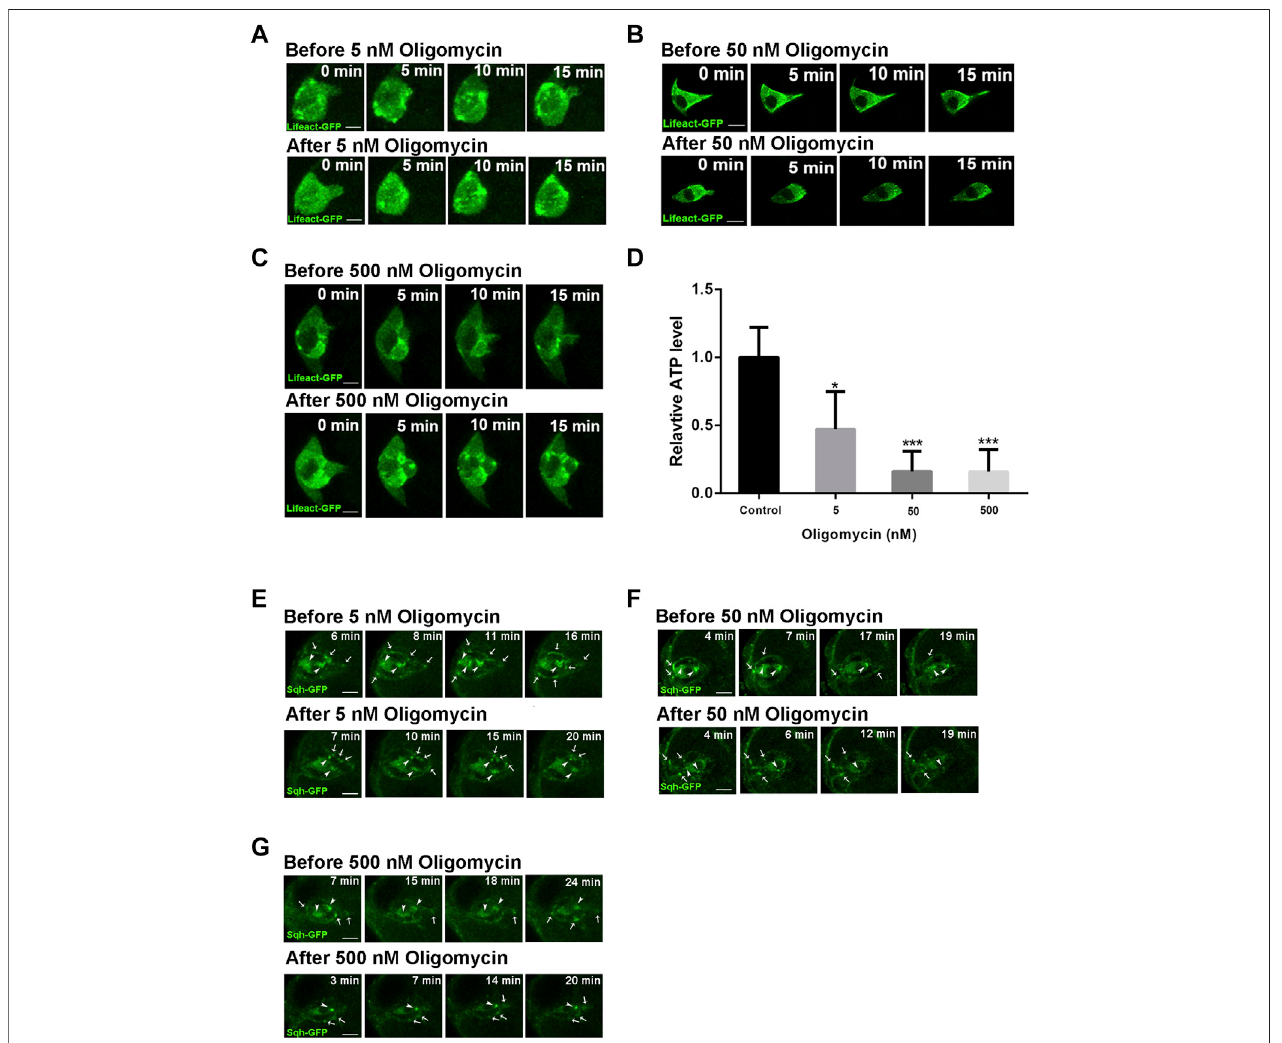
FIGURE 3 | Actin and myosin dynamics are affected by ATP level reduction during border cell migration. (A – C) Before treatment of early stage nine egg chambers by 5,50,and 500 nM Oligomycinrespectively, theborder clusters undergodynamiccellshape changes,extend longleadingprotrusion, and exhibitstrong dynamics of F-actin enriched patches. Less than 5 min after Oligomycin treatment, border cell clusters retract the leading protrusion and shape change and dynamic movement of F-actin patches were much reduced, with the effects by 50 and 500 nM treatment (B,C) more severe than that by 5 nM treatment (A) . See Supplementary VideosS5 – 10 formore details. (D) The ATPlevels ofovaries weresigni fi cantlydecreased after treatmentof5, 50and 500 nM Oligomycinascompared withthe control (treatedwithDMSO). (E – G) Beforetreatmentofearlystagenineeggchambersby5,50,and500 nMOligomycin,bordercellsexhibitdynamicmovementofSqh(Myosin